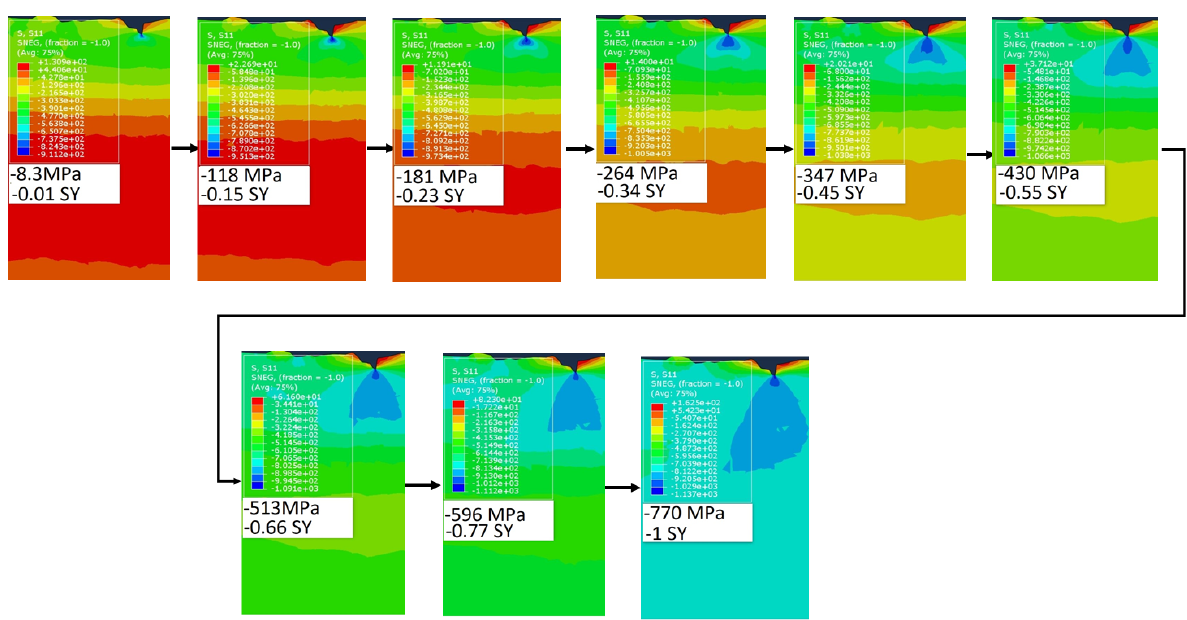
Figure 13. Stress distribution at different time steps of the loading with stress residual effect −320 MPa.